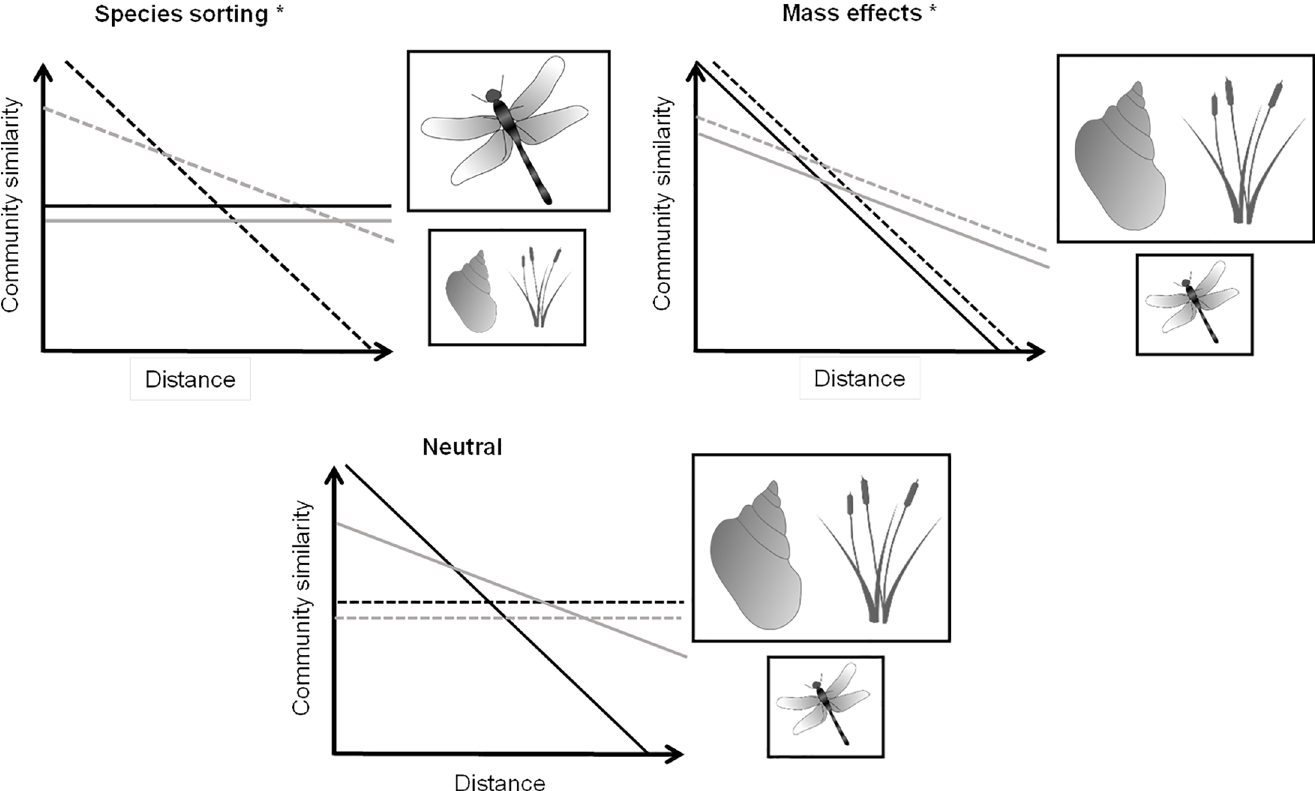
Fig 1. Conceptual scheme denoting the decrease in community similarity along geographic and environmental gradients taking into account the different types of metacommunity dynamics. The different sizes of organism symbols represent the higher (big symbol) or lower (small symbol) importance of the type of metacommunity dynamics for each biotic group. Grey lines indicate the response in the LEPN (large extent pond network) and black lines in the SEPN (small extent pond network). Solid lines indicate geographic distance, and dashed lines indicate environmental distance. The asterisk denotes the types of metacommunity dynamics that increase in importance at the surveyed small spatial extents [32,34].The figure is modified from Heino [12]. Credits: Symbols courtesy of the Integration and Application Network, University of Maryland Center for Environmental Science